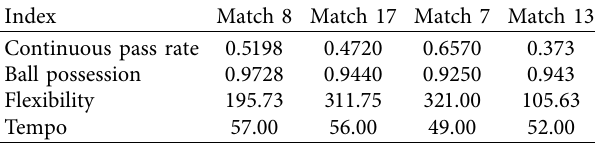
Table 7: The performance indicators of the four